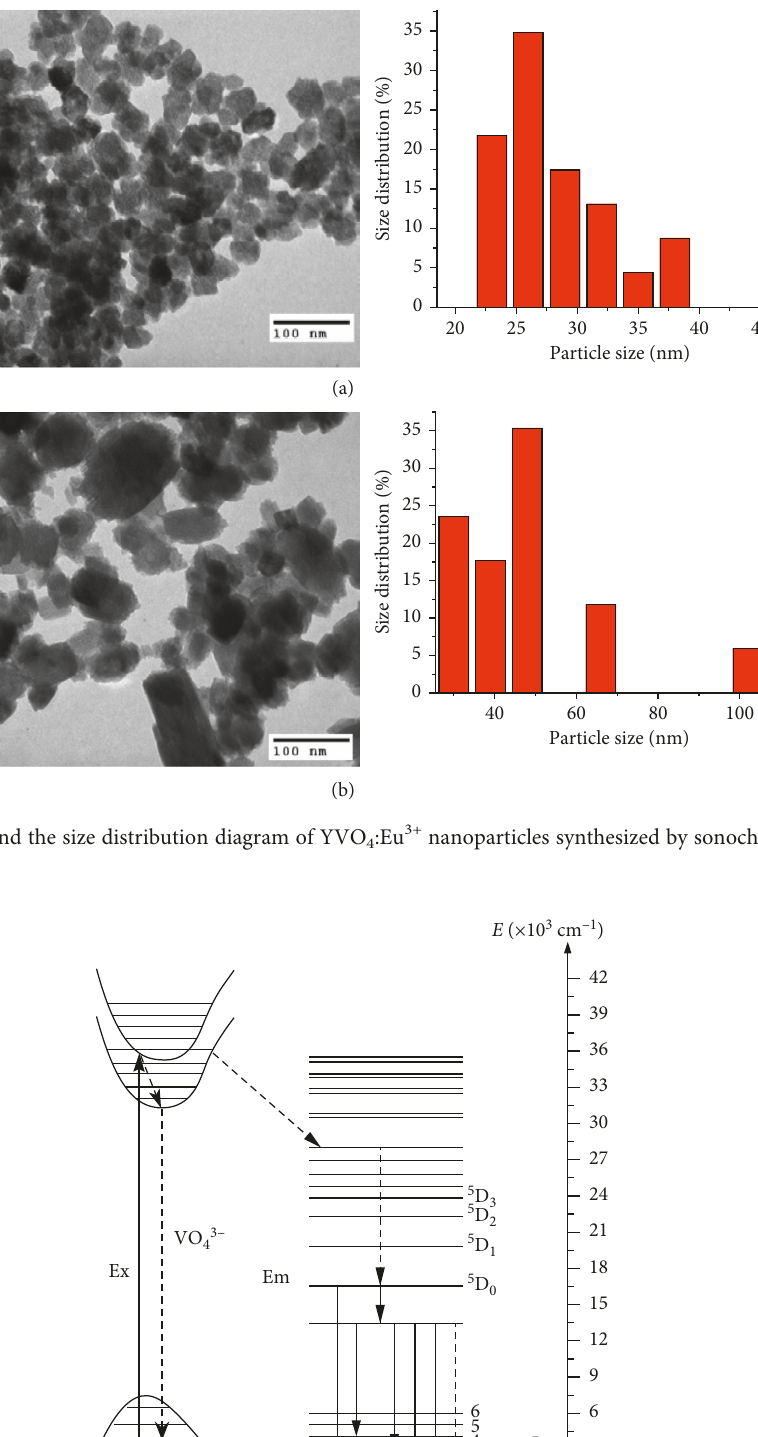
Figure 3: Energy levels and transitions scheme of Eu 3+ . Vertical arrows: absorption and emission sonochemical method, under excitation at 254 nm by the UV ions to the YVO 4 lattice. And, it leads to the highest in- lamp. The powder turns red under the UV lamp corre- tensity of emission peak [51]. Figure 4 (right inset) is the sponding to dominant emission at 618 nm. image of YVO 4 :Eu 3+ nanoparticles powder, synthesized by